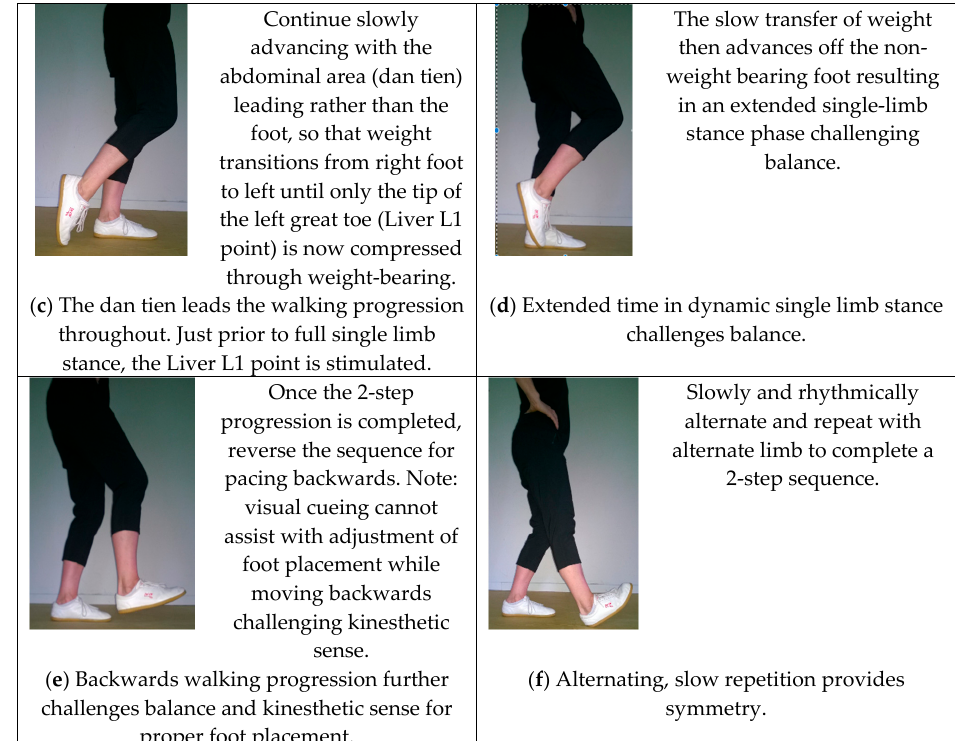
Figure 4 . ‘Pacing Forwards and Backwards’. Intent and purpose of the exercise progression as well as performance instructions are provided within the